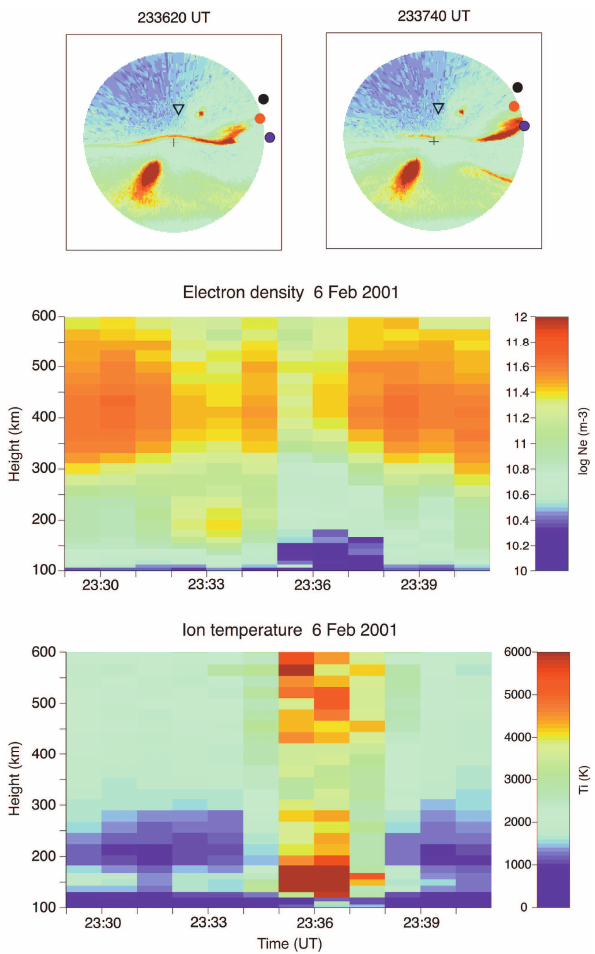
Fig. 22. (top) Abisko all-sky camera pictures from two time inter- vals of cavity formation with Cluster (1=black, 2=red and 4=blue) locations mapped. The triangle indicates the location of EISCAT. Moon is visible in the lower left part and an artificial light spot pole- ward of the arc. (bottom) EISCAT radar measurements of electron density and ion temperature. (From Aikio et al., 2004.)